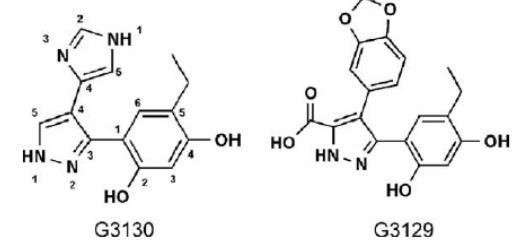
Figure 1. Structures of the identified dihydroxyphenylpyrazole